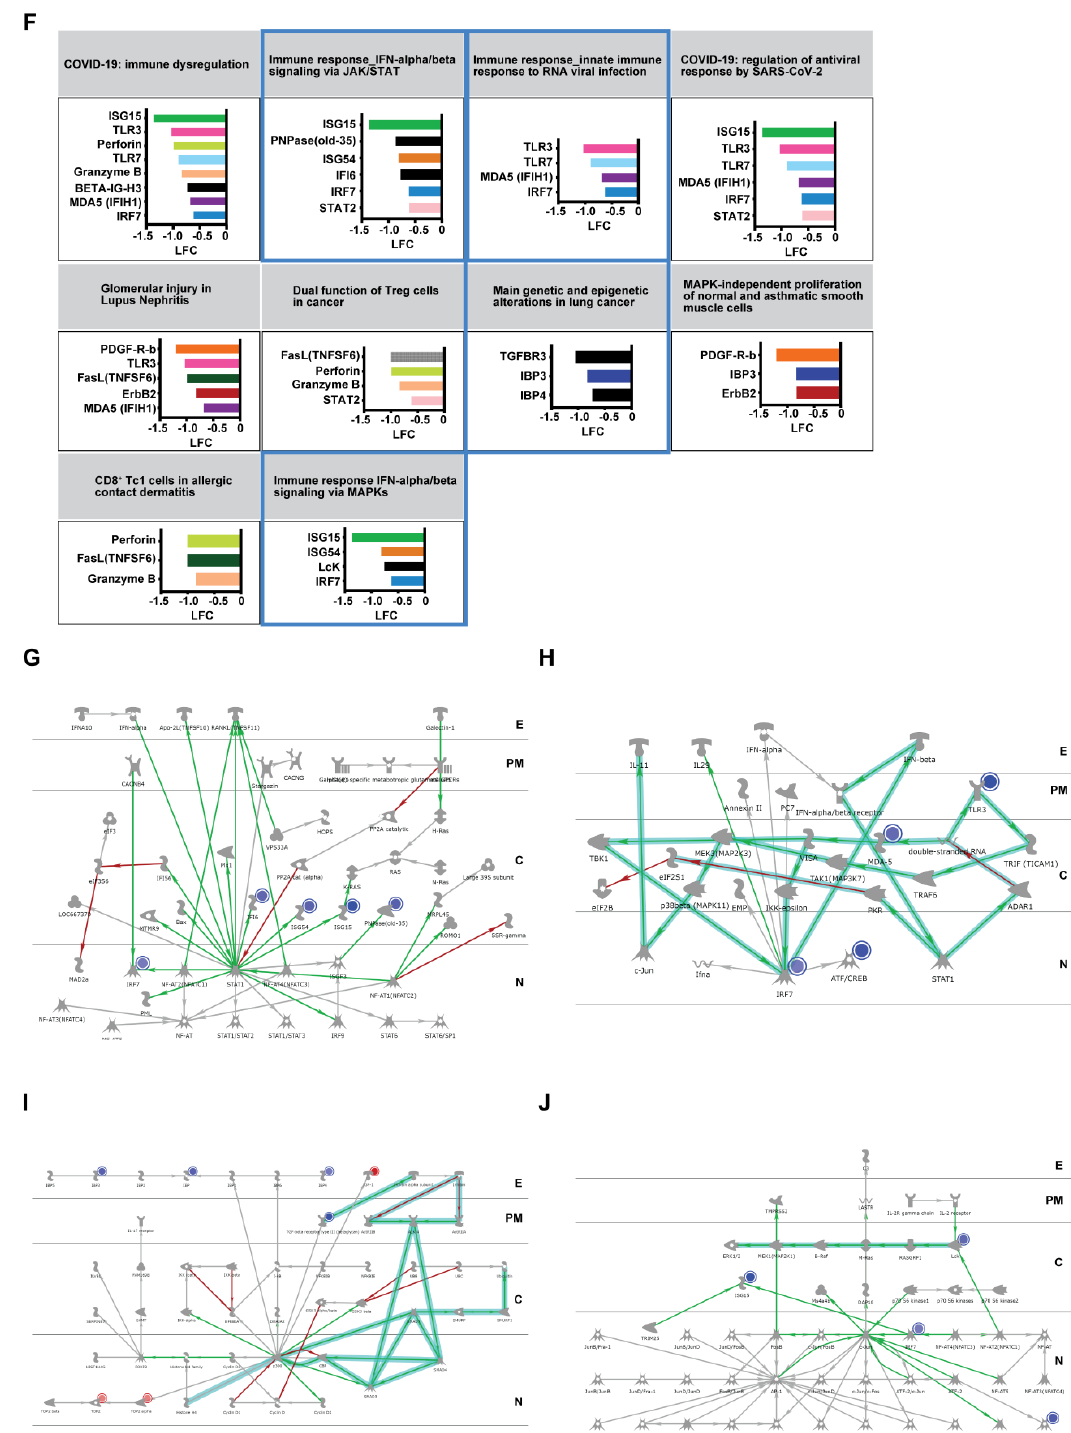
Figure 4. Metacore network analysis of genes from the enriched pathways. ( A ) Bar diagram showing Log 2 fold change (LFC) of the genes that contribute to enrichment of the top 10 pathways from Figure 3D (Svre vs. MldMod_UP). Network analysis of the genes from four of the ten pathways (highlighted in red) were shown in ( B ) IGF1 signaling in HCC, ( C ) plasminogen activators signaling in pancreatic cancer, ( D ) transcription HIF-1 targets, ( E ) IL-6 signaling in colorectal cancer. ( F ) Bar diagram showing Log 2 fold change (LFC) of the genes that contribute to enrichment of the top 10 pathways from Figure 3E (Svre vs. MldMod_DOWN). Network analysis of the genes from four of the ten pathways (highlighted in blue) were shown in ( G ) IFNa/b signaling via JAK/STAT, ( H )